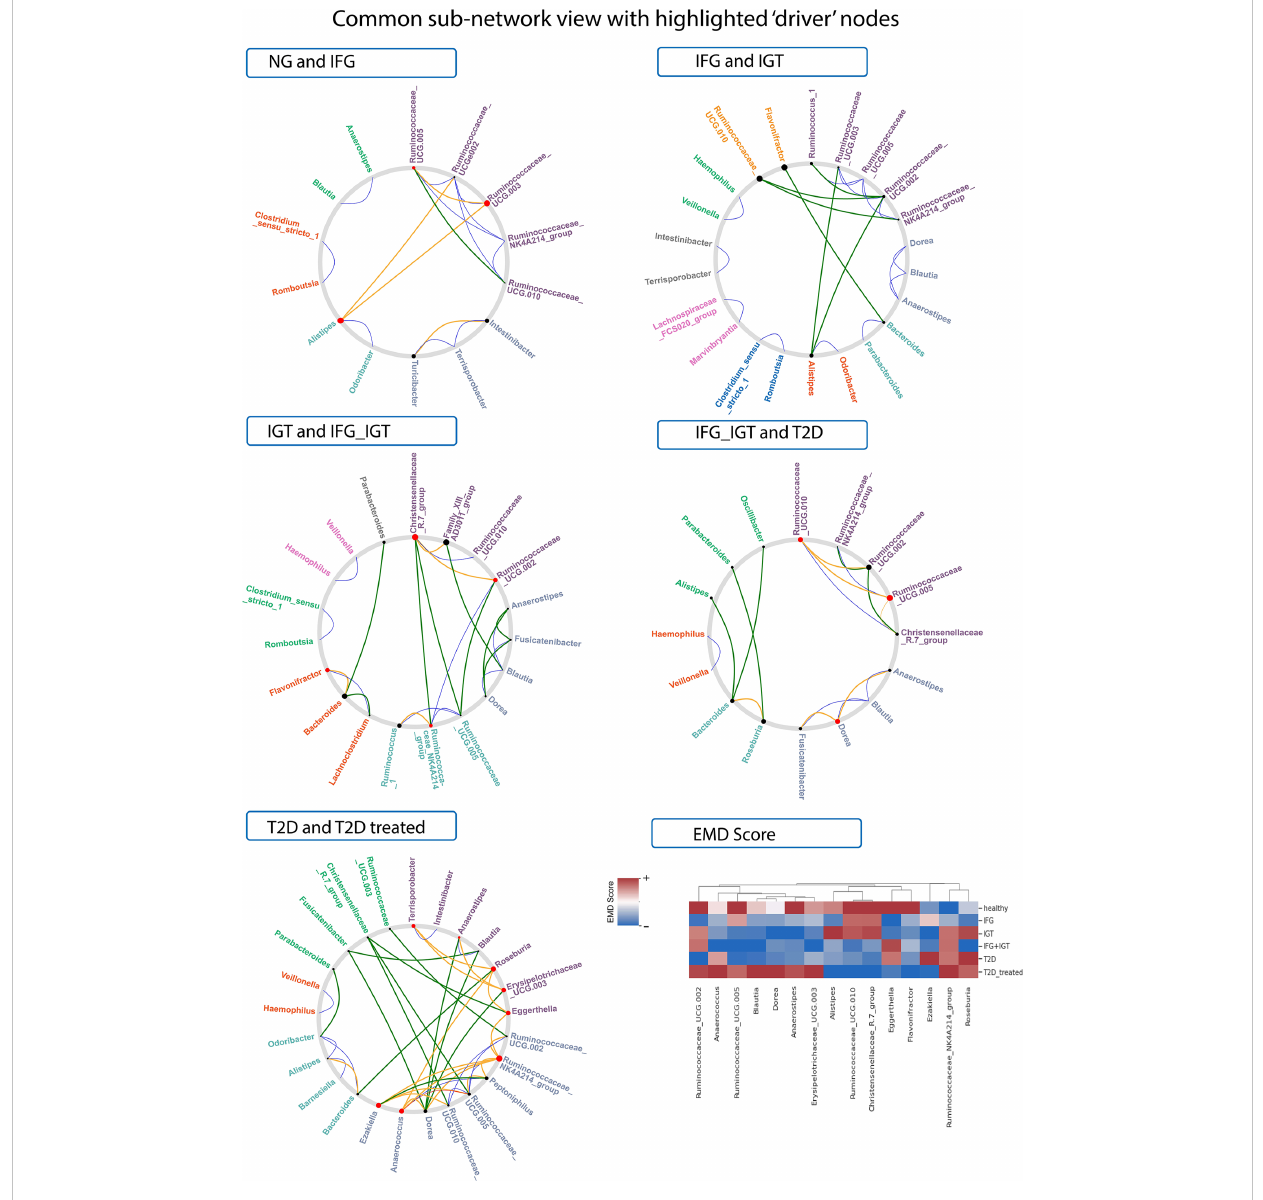
FIGURE 3 Driver nodes were obtained with NetShift. Driver nodes were colored red, edges present in both states were colored with blue, edges colored with green were exclusive to control data, and edges colored with red were exclusive to case data. All comparisons are based on a control-case order. Heatmap of the key drivers shifts among T2D states based on the denoised data, the earth-mover distance (EMD) is used to quantify distribution shifts among the T2D states